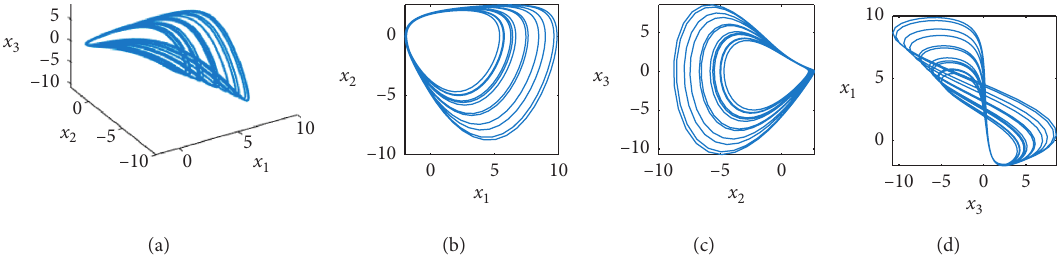
− x − x plane, x plane, and x 1 2 2 3